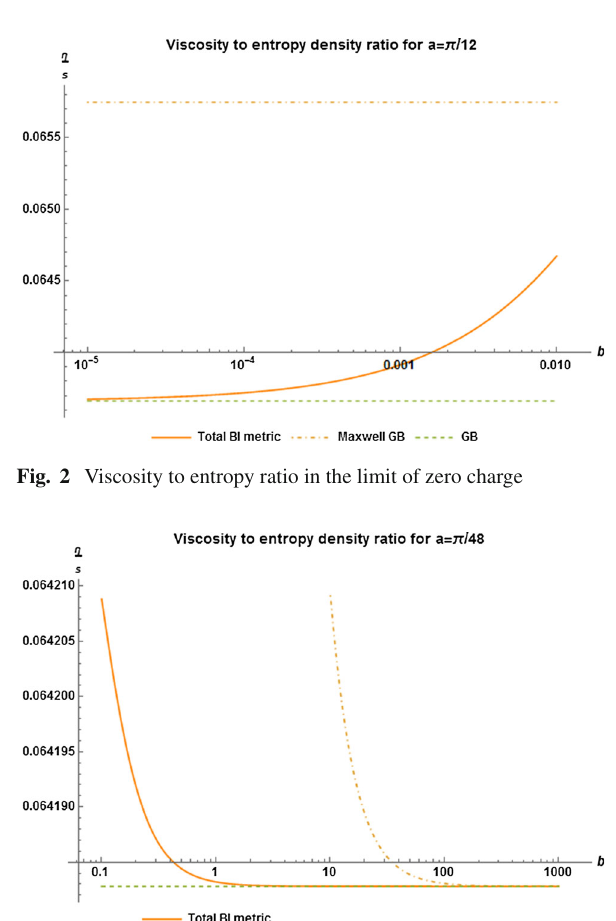
Fig. 1 Viscosity to entropy ratio for small value of BI parameter